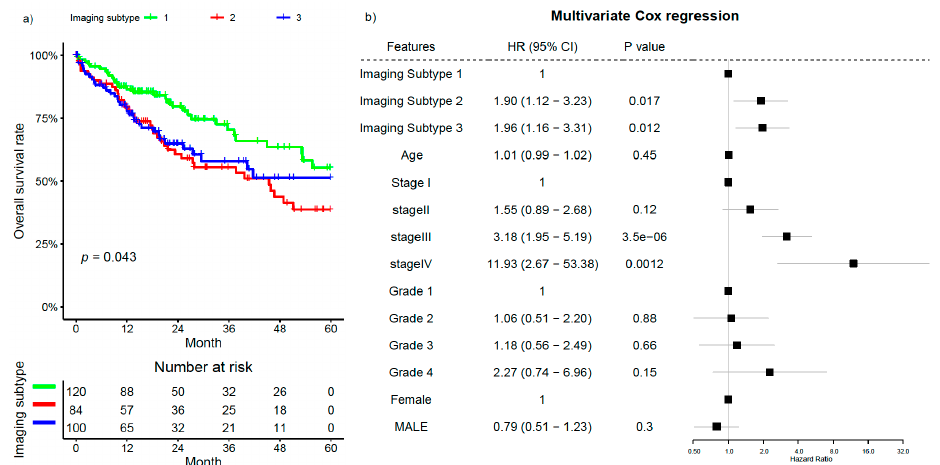
Figure 6. Kaplan–Meier curves for overall survival of patients stratified by the imaging subtypes ( a ), and forest plot for the multivariate Cox regression analysis ( b ) in the TCGA cohort. Imaging Subtype 1, Stage I, Grade 1, and female were used as the baseline in multivariate analysis.